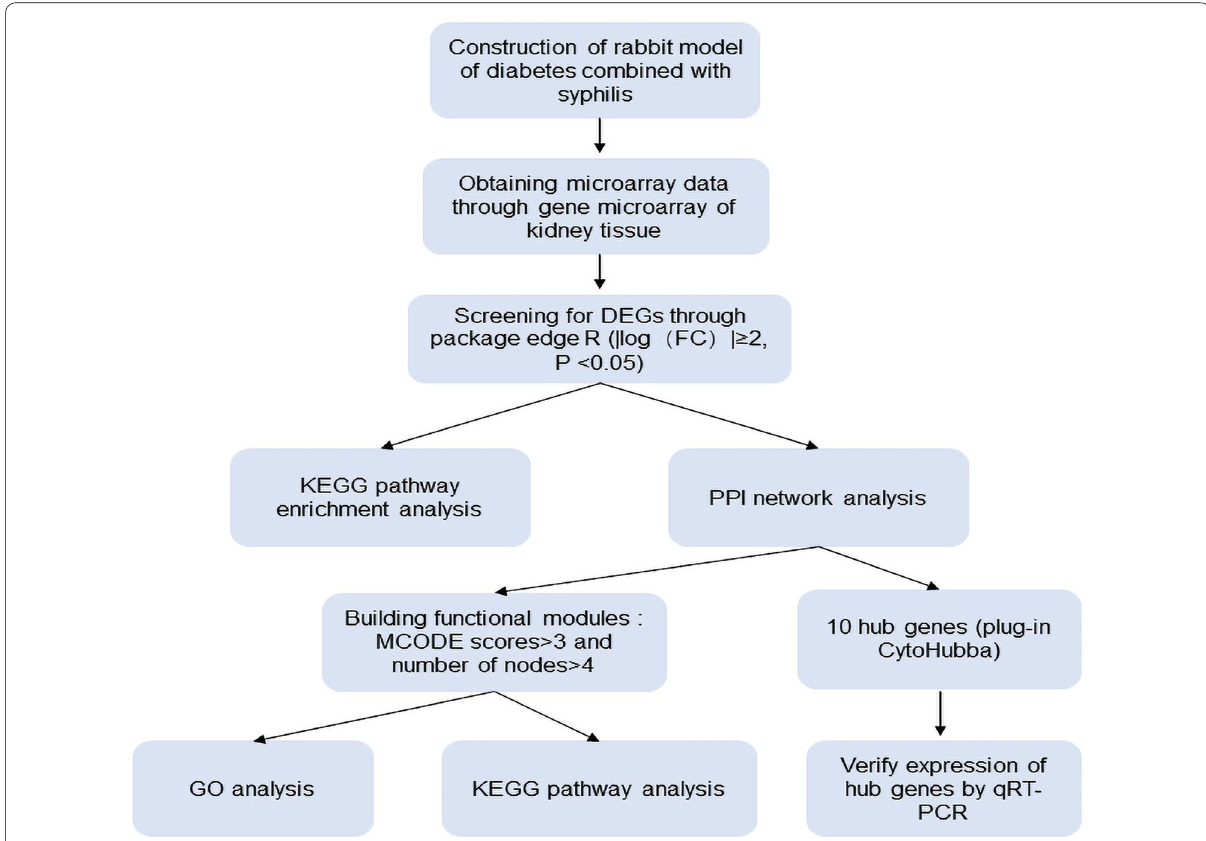
Fig. 1 Flowchart for the analysis